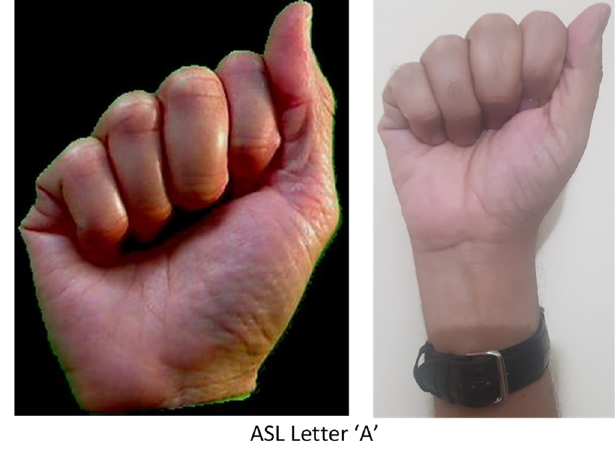
Figure 20. Detecting other objects—wristwatch scenario 1.